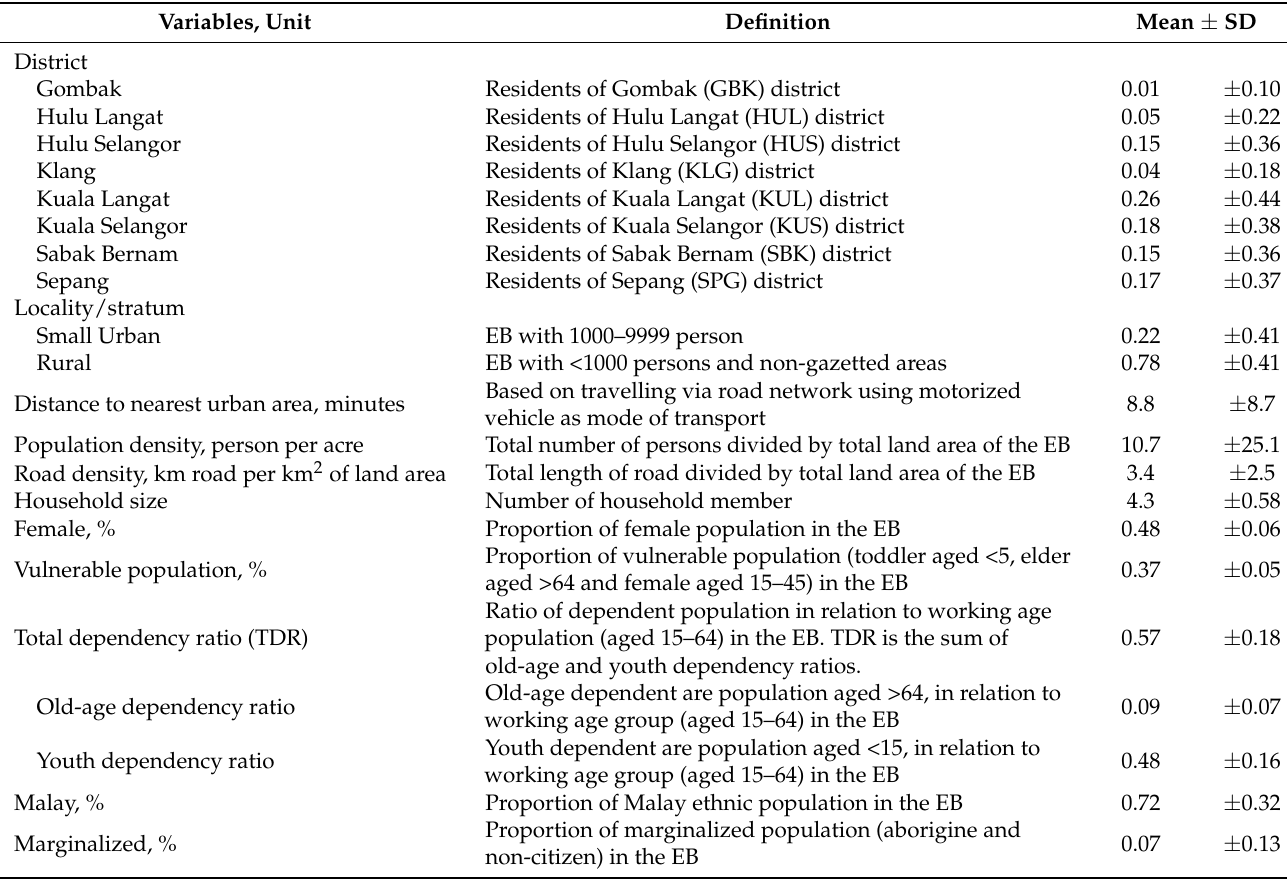
Table 1. Descriptive information of study population